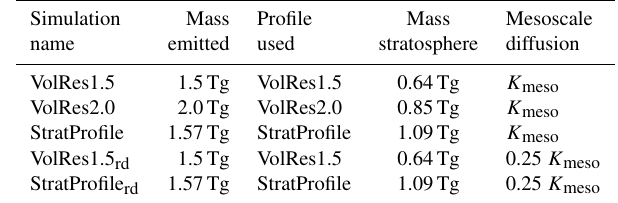
Table 2. Overview of the NAME simulations performed using dif- ferent emission profiles and a reduced mesoscale diffusion (values for K meso can be found in Table 1). Also shown is the estimated mass emitted into the stratosphere. For the actual vertical emission profiles, see Fig. 2. All the simulations use the same NWP data input (Global MetUM), the same emission location (48.3 ◦ N, 153.2 ◦ E), and duration between 21 June 2019 18:00UTC–22 June 2019 03:00UTC. The simulation domain is the NH between 25–90 ◦ N and the simulation length is